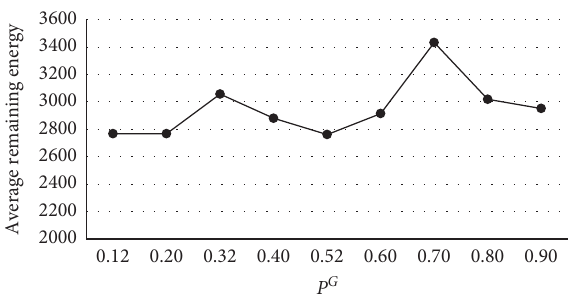
Figure 5: Average remaining energy with different relief probabilities of government.